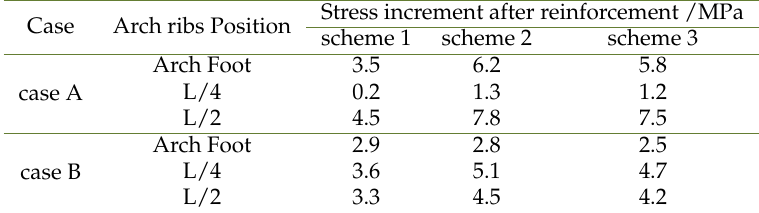
Table 2. Compressive stress of chord on arch rib